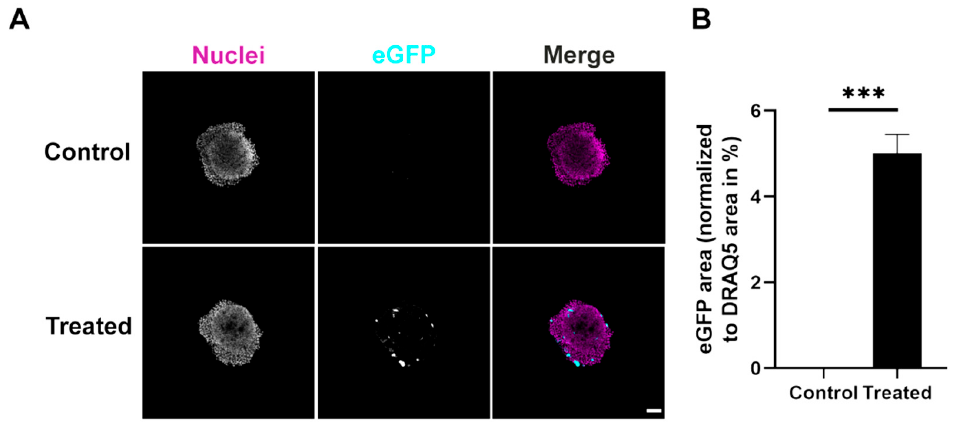
Figure 5. Triculture spheroids show reduced expression of the eGFP reporter protein compared to monocultures upon eGFP LPX transfection. For each triculture spheroid, identical amounts of cells were used and transfected with 10 ng/µL eGFP LPX (treated). Control, PBS only. Afterwards, spheroids were fixed and stained for nuclei ( A ). Shown are single confocal sections through the center of representative spheroids. In merge images, nuclei and eGFP are shown in magenta and cyan, respectively. Scale bar, 100 µm. ( B ) Quantitative analysis of the eGFP area normalized to nuclei area. Mean + SD ( n = 3 independent experiments, at least 3 spheroids per condition). T test (two-tailed, unpaired, ( α = 0.05), *** p ≤ 0.001).